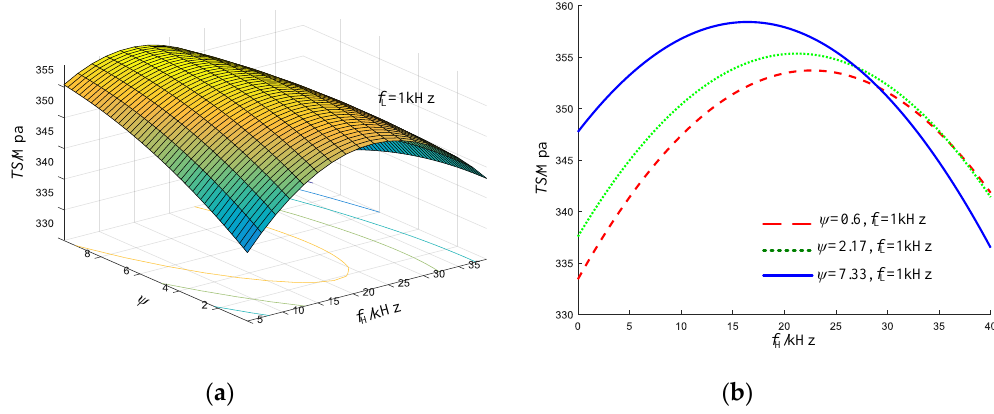
Figure 4. Contour plot of surface on tensile strength ( TS ): ( a ) contour plot of surface that f L is 1 kHz; ( b ) interaction of f H and ψ.